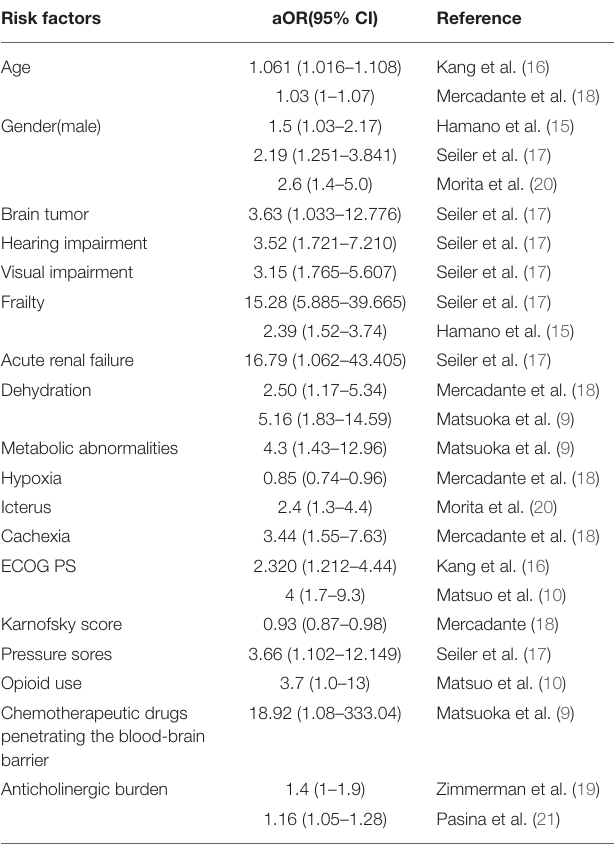
TABLE 2 | Multivariable analyses of risk factors for delirium in palliative care population. Risk